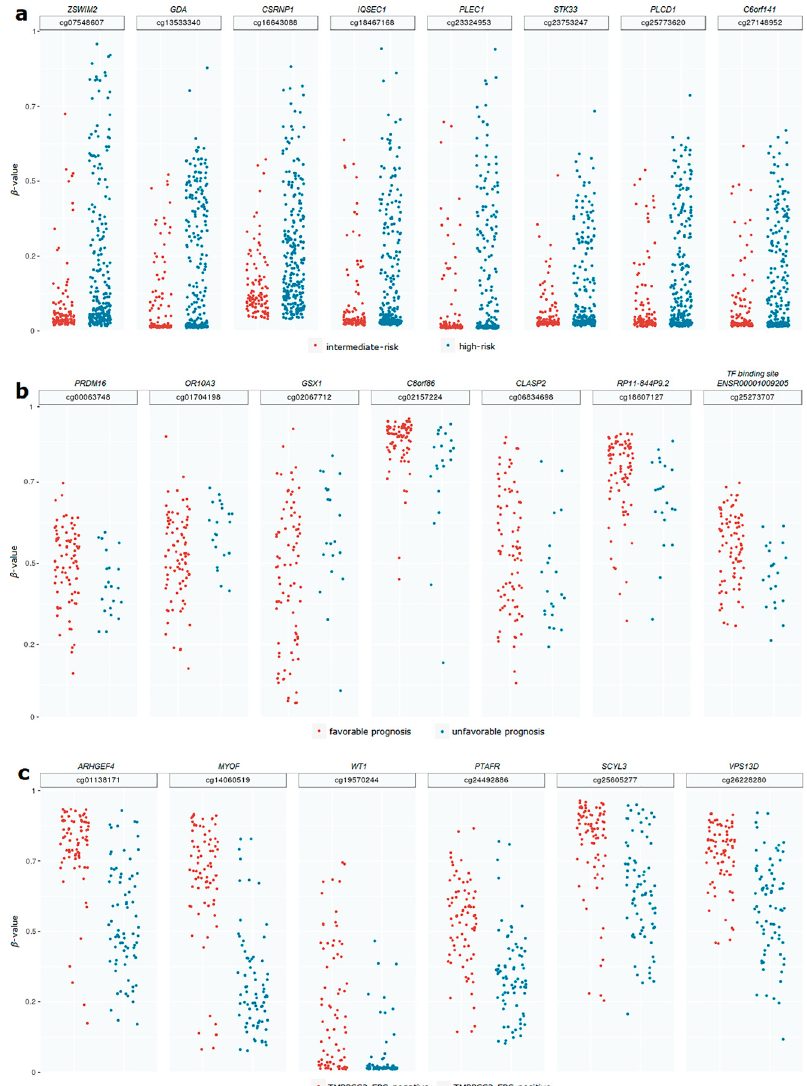
(c) Differentially methylated TMPRSS2-ERG